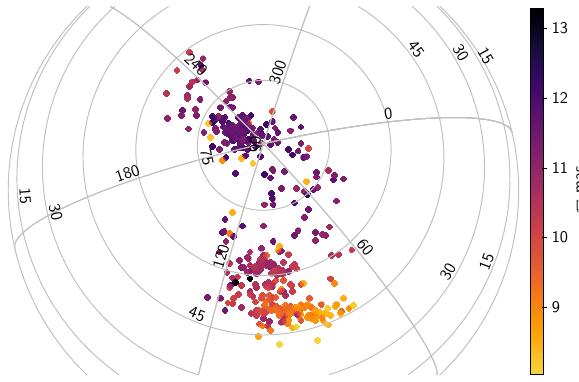
Figure 8. Position of stars – probable members of Coma Ber and Group X at the celestial sphere and in space. Colour marks EDR3 parallaxes of stars, darker colours represent closer stars. Coordi- nate frame is Galactic (l,b)